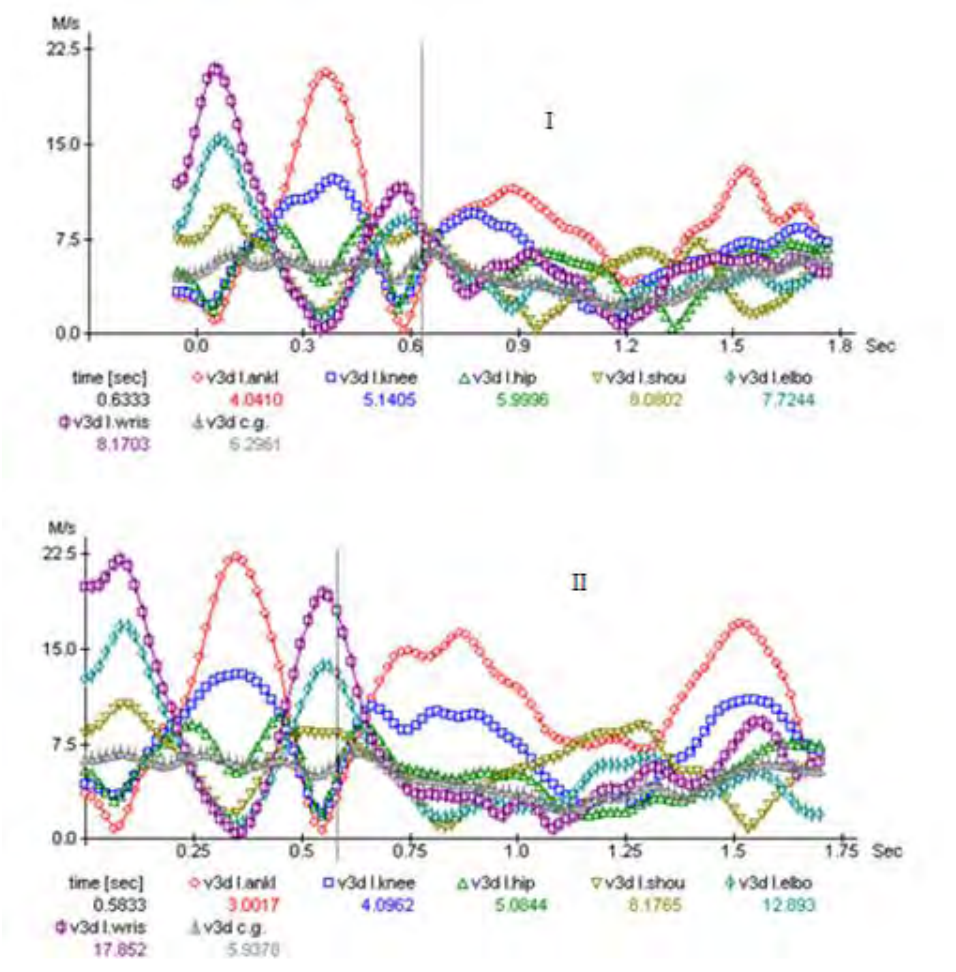
Fig.2. Starting posture of body. Resultants of speed of ankle, hip, elbow, shoulder and wrist joints as well as GMC of sportsmen’s bodies during short term fixing of starting posture for grouped back double somersault after rondat (tested A, upper section of figure, variant 1) and arched back double somersault after rondat-back turnover (tested B, lower section of figure, variant 2). : ankle –ankle joint; knee – knee joint; hip – hip joint; should – shoulder joint; elbow – elbow joint; wrist – wrist joint; c.g. – general mass center of body (GMC). Phase of main movements. Key element of sport technique is multiplication of postures (MP) “grouping” and “straightening” with insignificant bending in hip joints. Sportsmen fulfill first somersault on ascending part of flight trajectory in structure of double somersault (variant 1, time 1. 033sec., angle hip – body equals to 69. 30°; variant 2, time 0. 917 sec., angle hip – body equals to 151. 30°) (see fig.